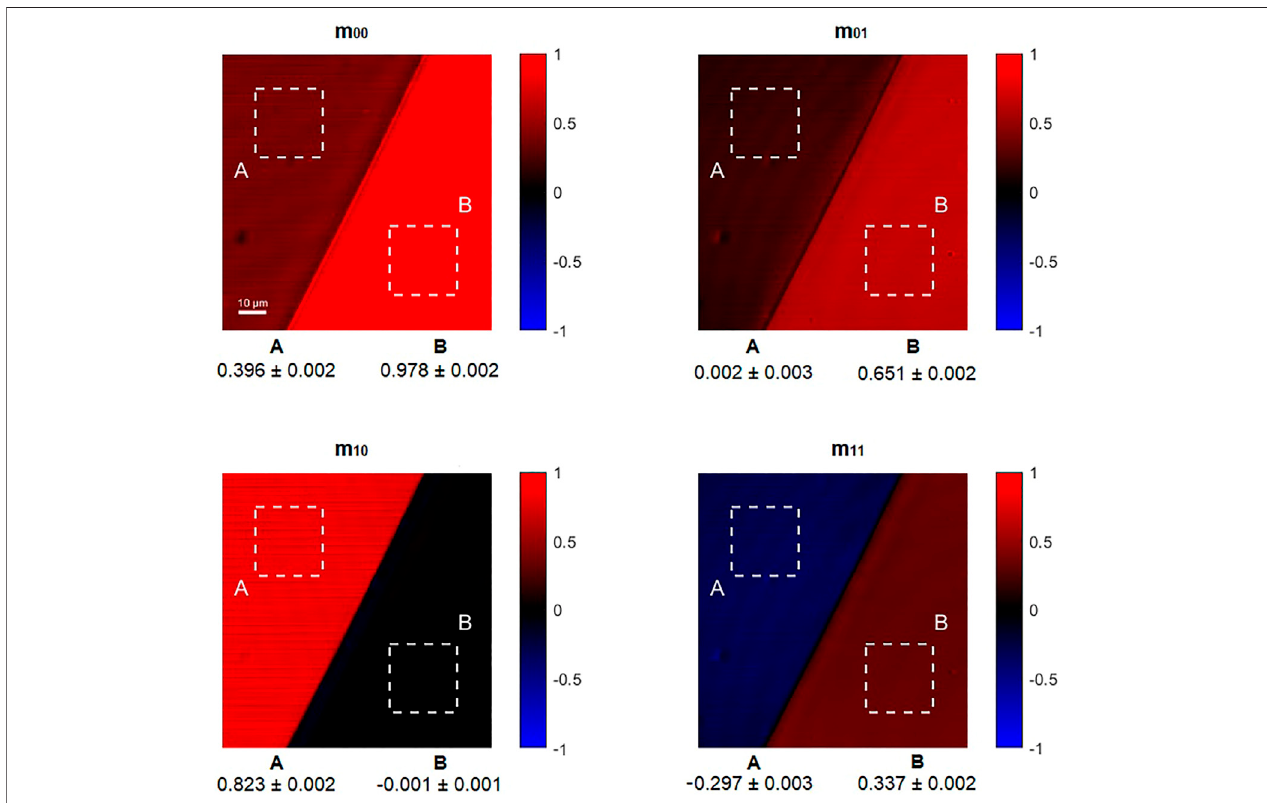
FIGURE 2 | A Linear Polarizer (region A) and a simple microscopy glass slide (region B) have been used as reference sample. In the bottom part of the images associated with each Mueller coef fi cient are reported the statistics (mean and standard deviation) of the pixels inside the dashed squares (A and B) for each Mueller